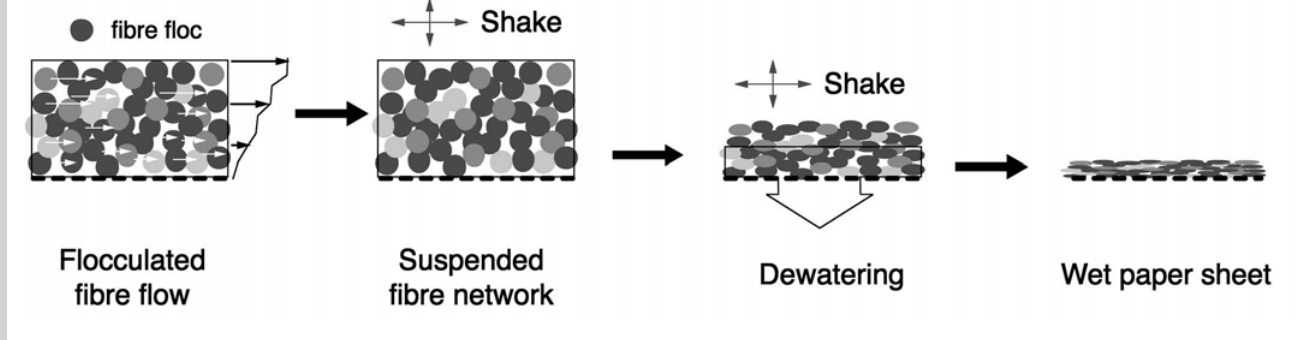
Figure A3: Formation of the paper sheet in a paper machine,